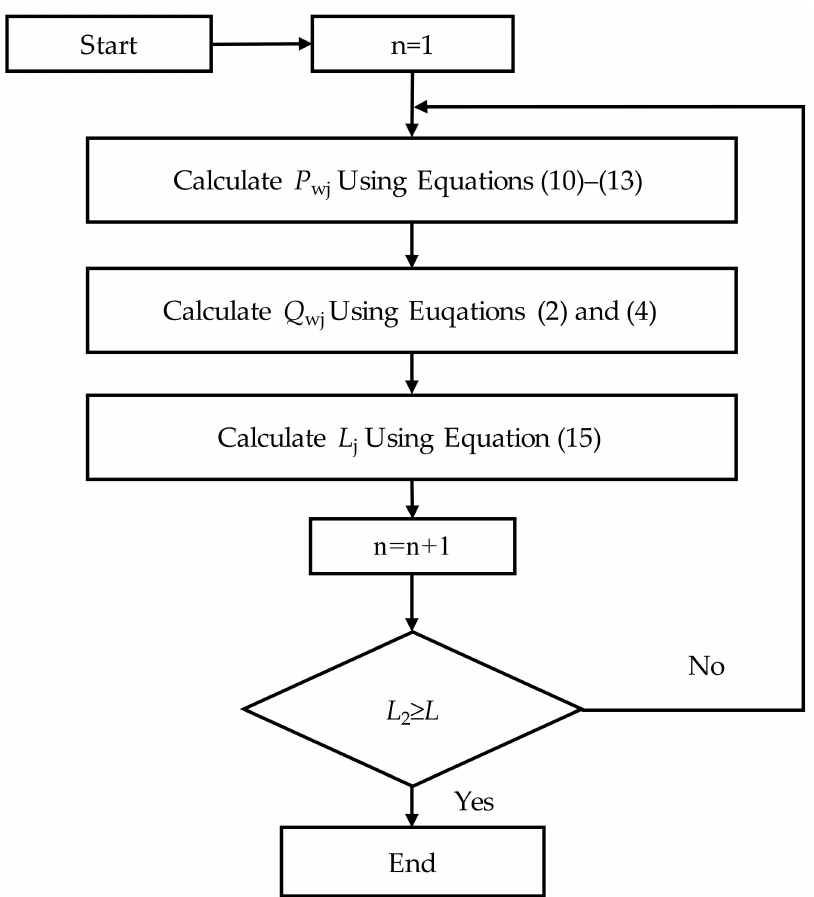
Figure 2. Flowchart of three capillary model calculations. P wj is the wetting-phase pressure near the imbibition front of the j capillary, Q wj is the flow rate of wetting phase in j capillary, L j is the advancing distance by water in j